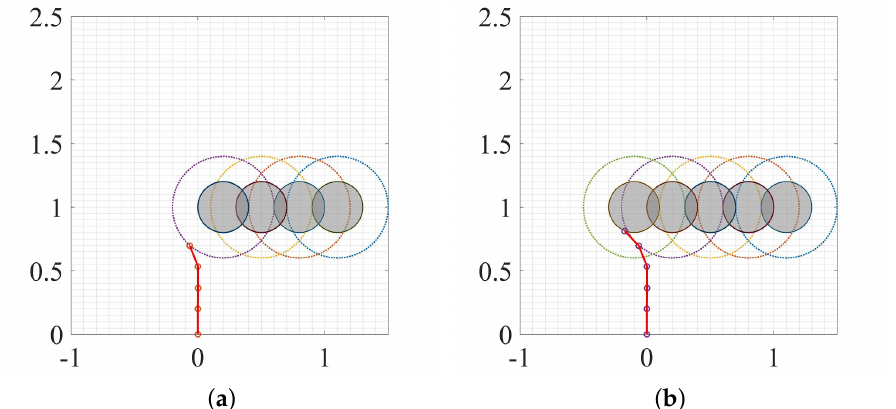
Figure 8. The robot uses the DAPF approach to avoid a fast moving obstacle: ( a ) shows that the robot is before obstacle avoidance, and ( b ) shows that the robot collides with an